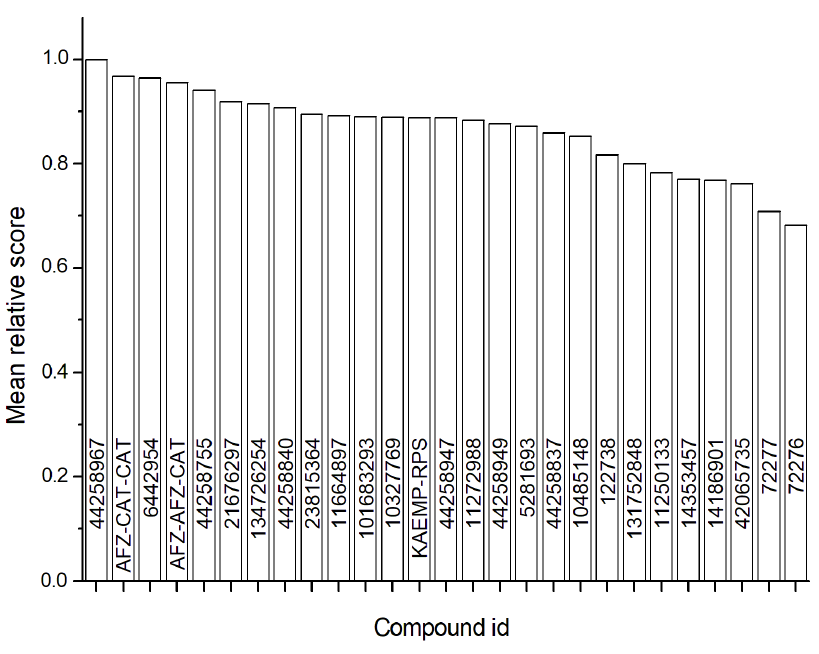
Figure 3. Mean relative docking scores of the compounds of the Monteverdia ilicifolia extract. The reference crystallographic ligand DJM (CID42065735) was used as reference.